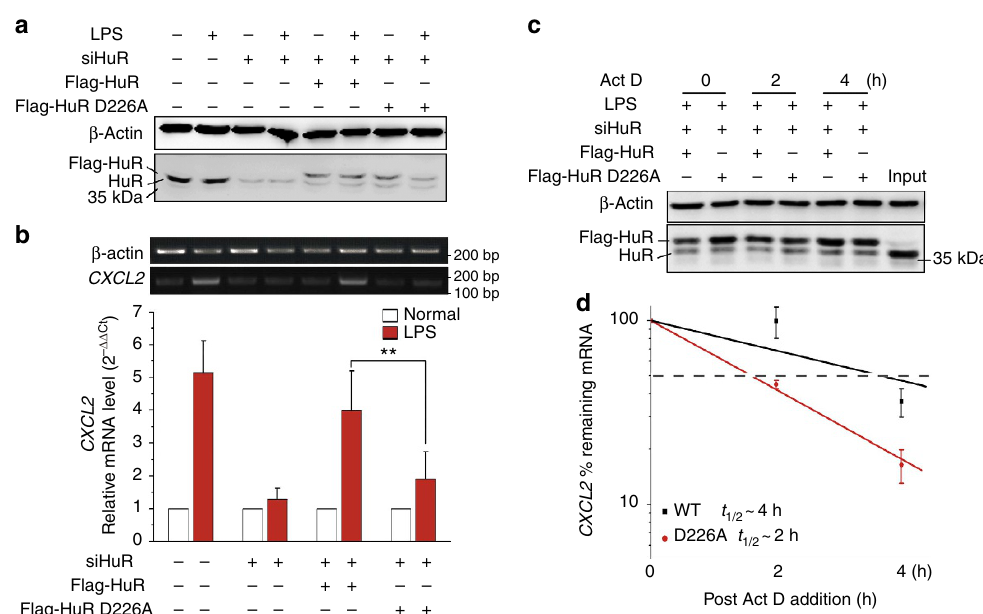
Figure 9 | The HuR D226 mutant is incapable to sustain the CXCL2 mRNA level. ( a , b ) CXCL2 mRNA expression is impaired in D226A HuR-expressing cells. Endogenous HuR in HEK 293 cells was silenced using siRNA-targeting a distinguished sequence of human HuR, and then murine WT HuR and D226A HuR expressional plasmids were transfected. Immunoblotting was performed to detect the interference of endogenous HuR, as well as the ectopic expression of Flag-tagged murine WT and D226A HuR ( a ). Cells expressing WT or D226A HuR were stimulated with LPS, or not for 2h. CXCL2 mRNA levels were detected by PCR with reverse transcription and electrophoresis (upper), or real-time PCR (lower) ( b ). ( c , d ) CXCL2 mRNA’s half-life is shortened in D226A HuR-expressing cells in response to LPS stimulation. The ectopic expression of murine WT HuR and D226A HuR in endogenous HuR-silenced HEK 293 cells was carried out and detected as described above. The last lane loaded with cell lysate from control cells serves as a marker ( c ). Cells expressing WTor D226A HuR were stimulated with LPS for 1h to boost inflammatory gene expression and then subjected to transcriptional inhibition for different lengths of time (as indicated). Real-time PCR was performed to assess the remaining CXCL2 mRNA levels. Half-lives of different samples are indicated in the inset. Data were expressed as mean ± s.d. ( n ¼ 5), and analysed by one-way analysis of variance. ** P o